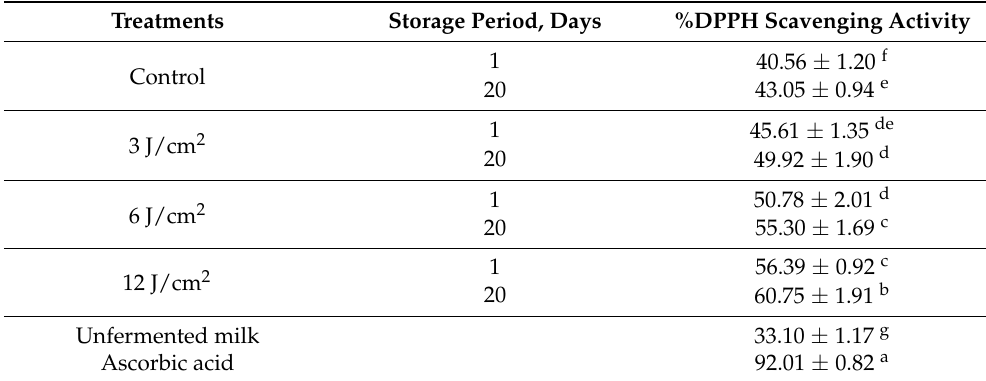
Table 3. Antioxidant activity as the DPPH-scavenging activity of different labneh